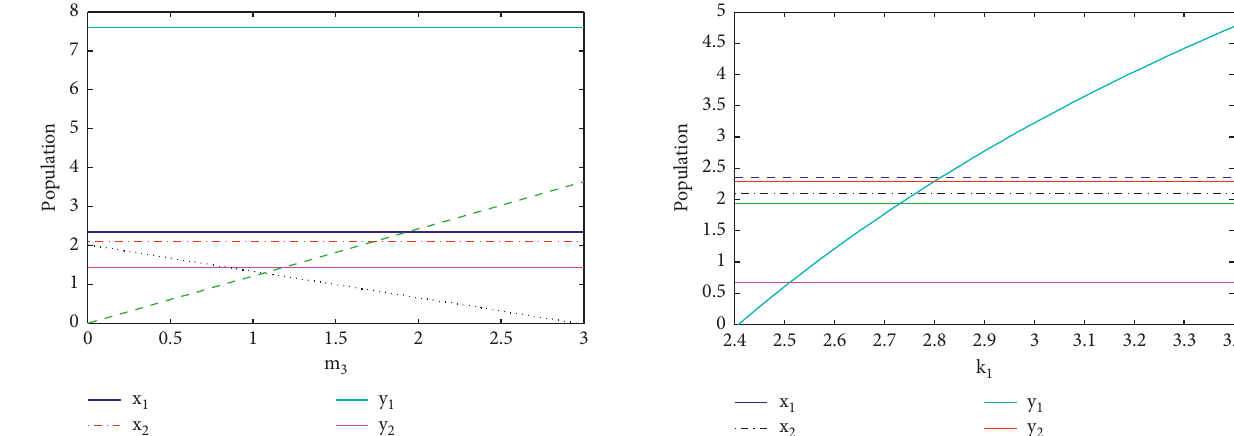
on all the species. 3